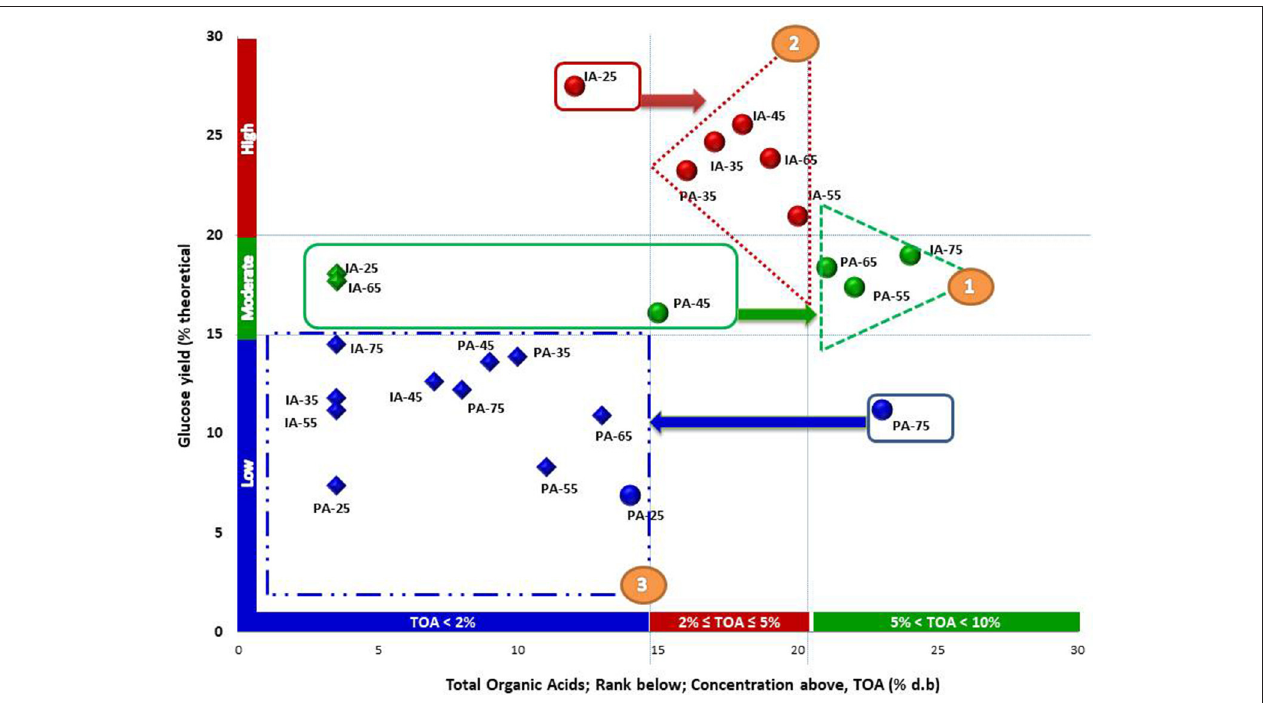
FIGURE 6 | Relationship between organic acids and fiber reactivity cluster grouping of PA/IA corn stover (without pretreatment) and grouped using ranks of mean glucose yields from cellulase enzyme loading of 15 FPU/g glucan and ranks of mean total acids. The ranks of mean glucose correspond with the percentage theoretical yields. Diamonds represent day 0 samples and circles represent day 220 samples. Numbers following IA and PA represent storage moisture content on a percent wet